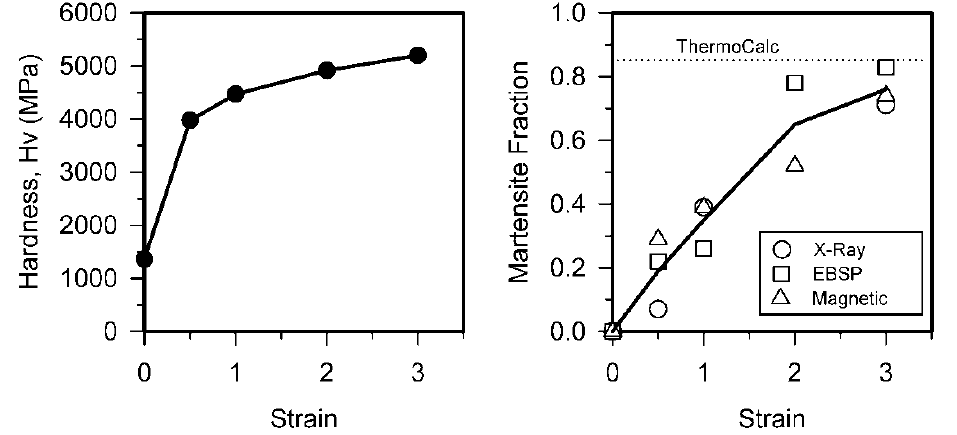
Figure 1. The effect of cold rolling strain on the hardness and strain-induced martensite fraction in a 304L stainless steel.